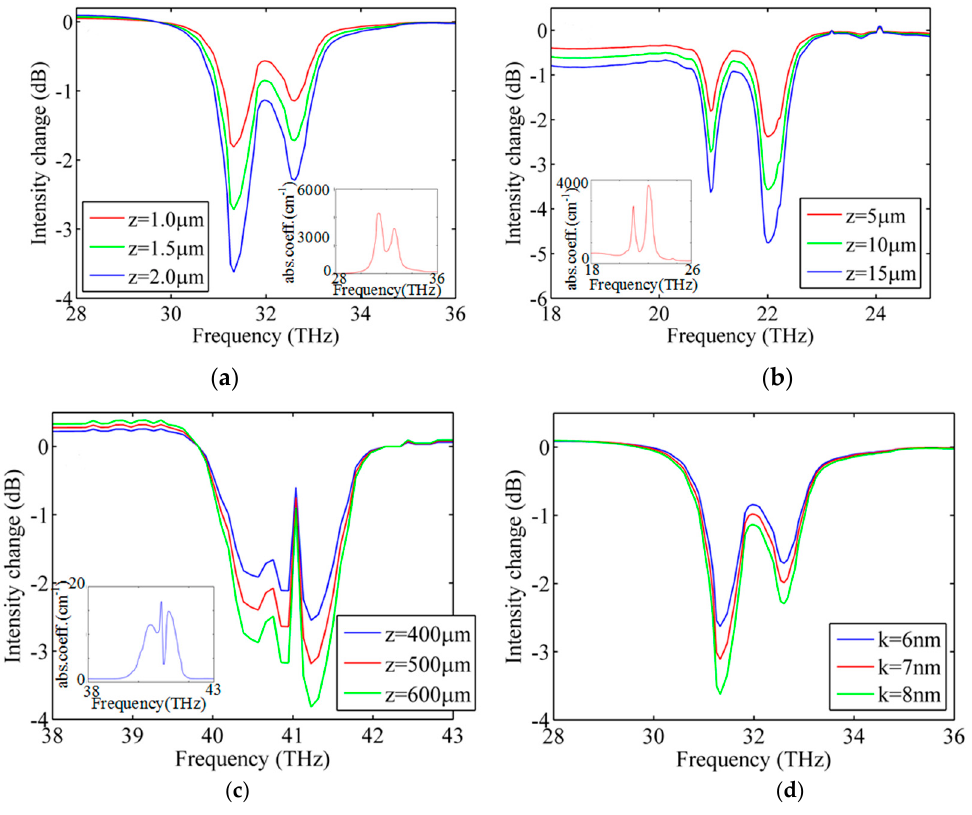
Figure 10. Intensity change caused by presence of analyte. ( a ) Ethanol; ( b ) Toluene; ( c ) Sulfurous anhydride; ( d ) Ethanol in different thickness. In panels “ a – c ”, the insets show the absorption spectrum of the analyte in the same frequency region as the main axis.